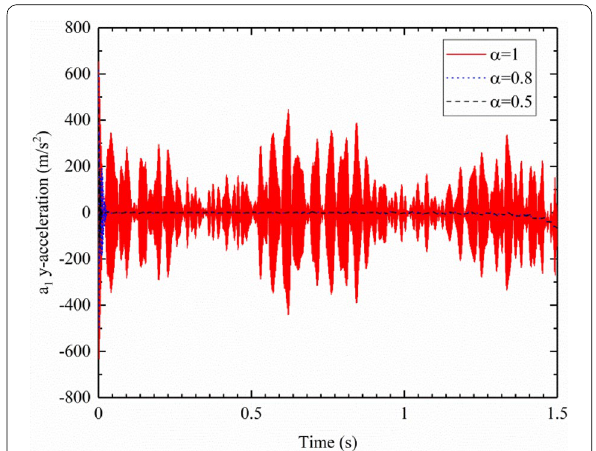
Figure 5 Y -direction acceleration of point a 1